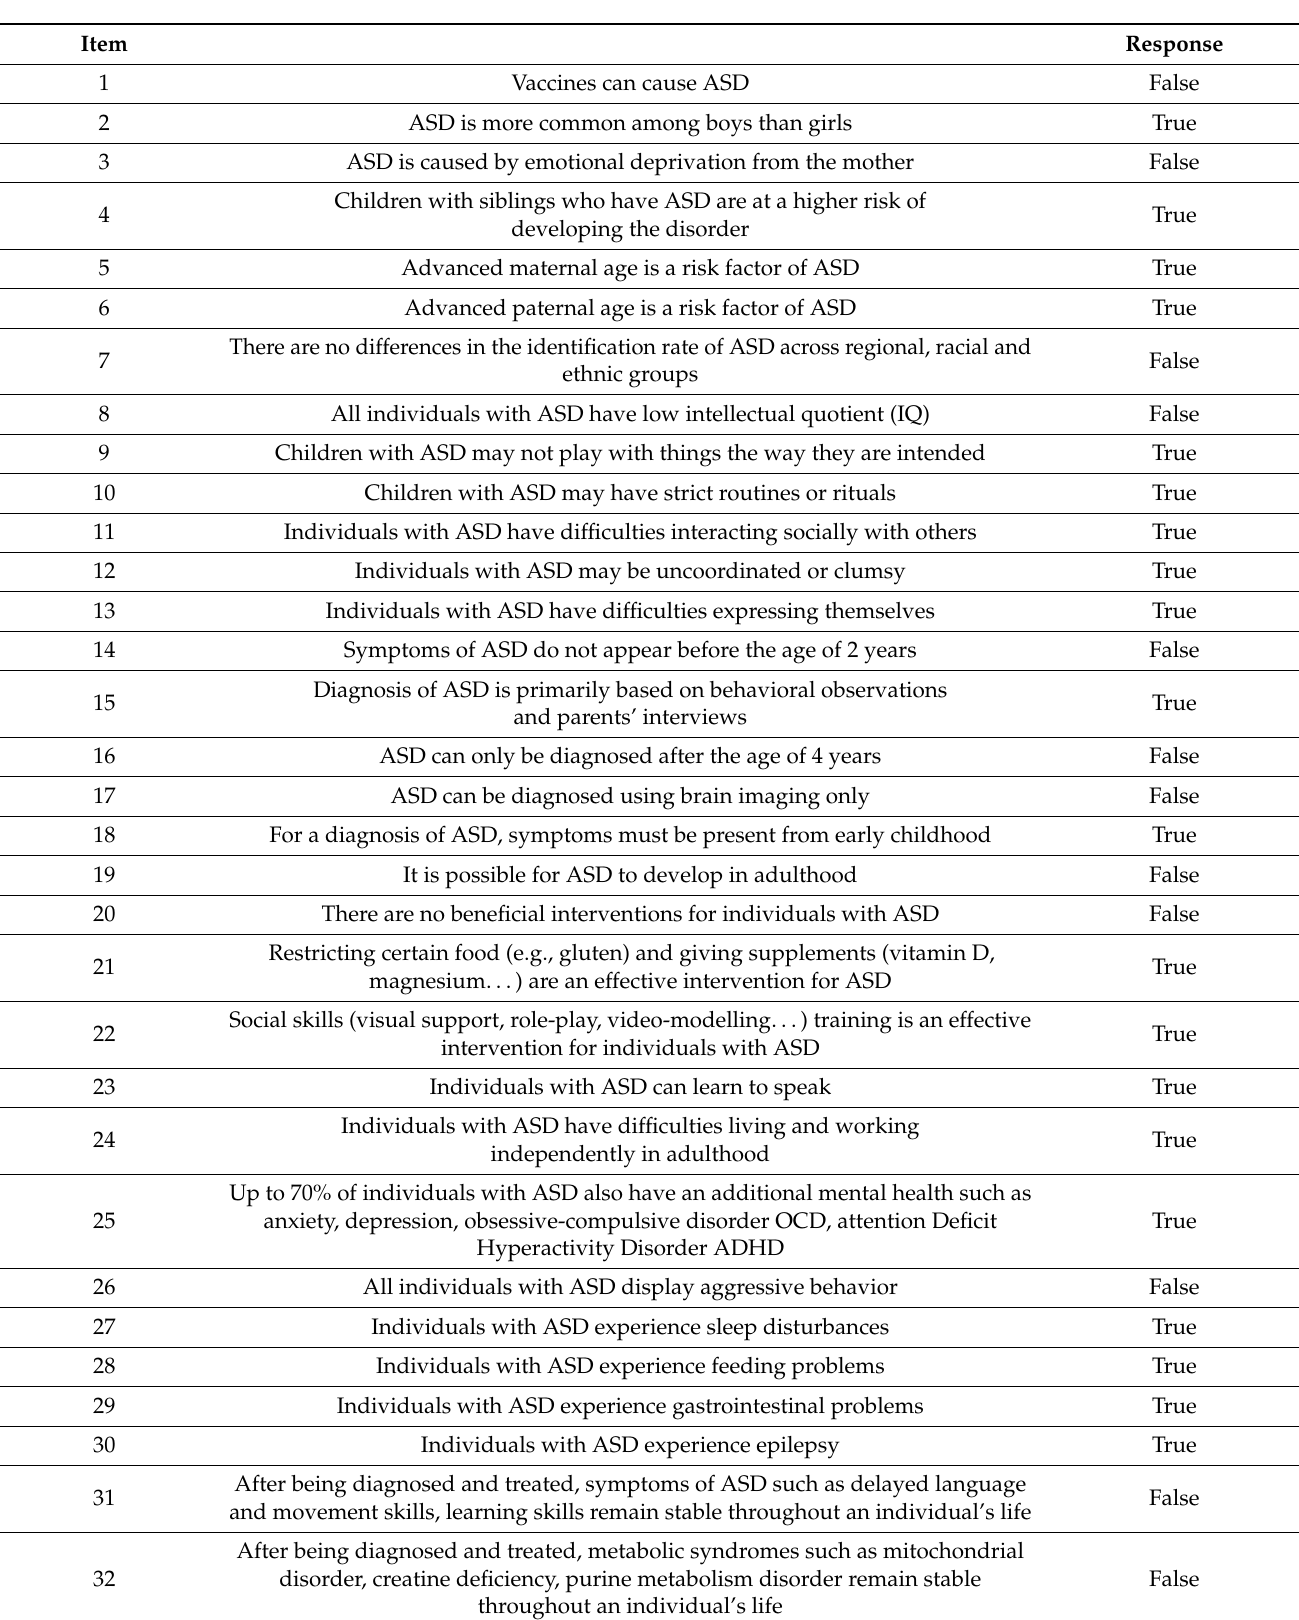
Table 1. Items and their